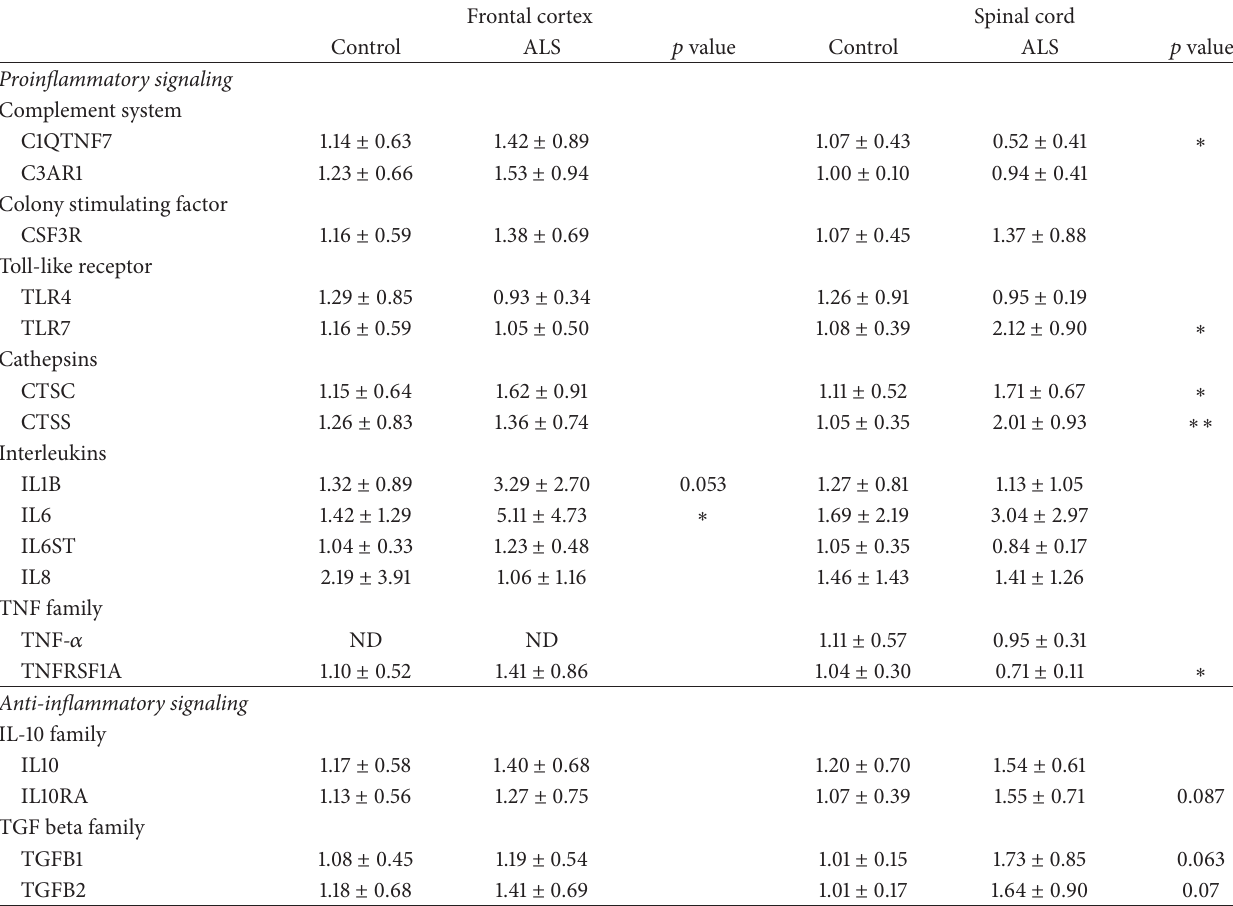
Table 3: Results of mRNA expression assessed by RT-qPCR using GUS- 𝛽 for